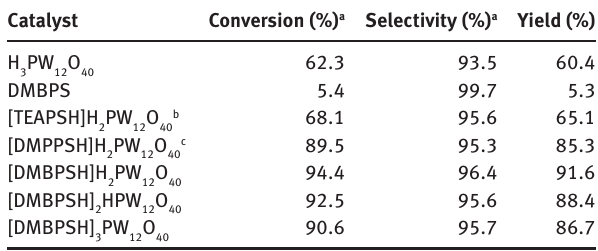
Table 1: Catalytic performances of various catalysts during oxida- O [reaction conditions: BzOH/H tion of BzOH with H 2 2 ratio = 1:2 (mol/mol); amount of catalyst = 5 wt%; reaction time = 3 h; amount of water = 20 ml; temperature 393